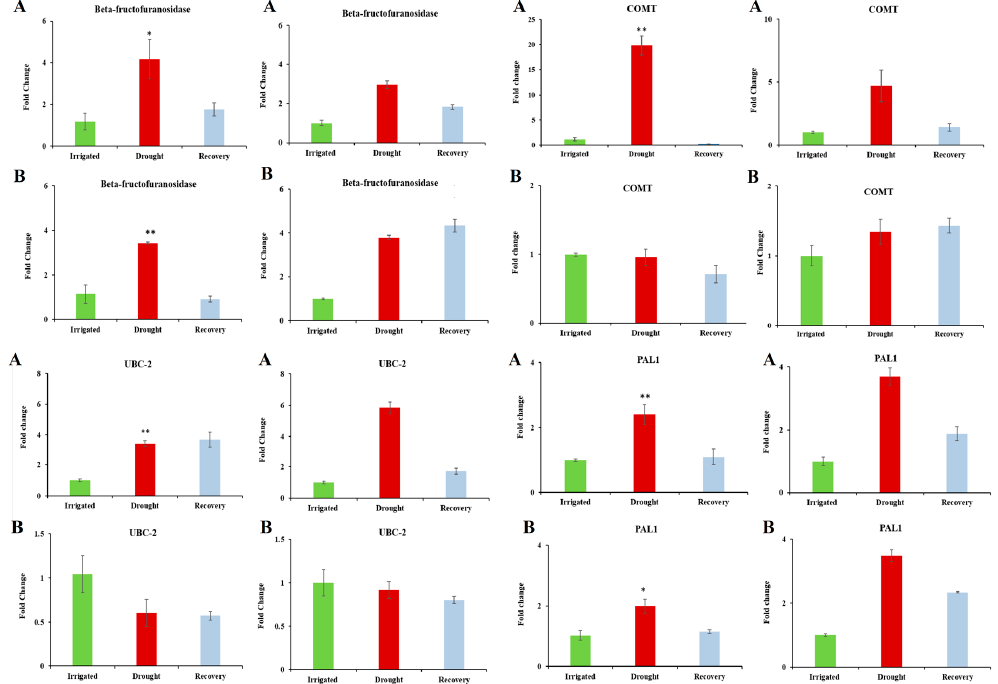
Figure 3. Comparison of qPCR and microarray intensity values: Rows ( A ) and ( B ) respectively refer to results for DipC and TN. The left- and right-hand pairs of columns correspond to the qPCR and microarray values for DipC and TN, respectively. The gene under study is named at the top of each panel. In order, the investigated genes are Beta-fructofuranosidase, COMT , UBC-2 , and PAL1 . qPCR and Microarray values are shown as fold changes with respect to the water-sufficient treatment (Irrigated). Error bars denote the standard error. Single and double asterisks indicate that p -value is less than 0.05 and 0.01, respectively, which was assessed by the paired t -test between groups. Irrigated and Drought refer to water-sufficient and water-limited treatments, respectively.